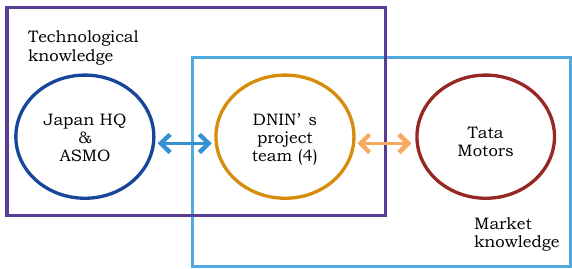
Figure 5. DNIN engineers as knowledge